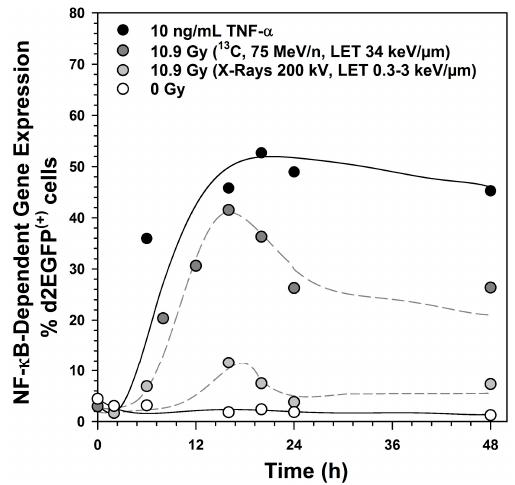
Figure 1. Kinetics of Nuclear Factor κ B (NF- κ B)-dependent destabilized enhanced green fluorescent protein (d2EGFP) expression after treatment with tumor necrosis factor α (TNF- α ), X-rays and carbon ions, as detected in stably transfected human embryonic kidney cells (HEK) cells